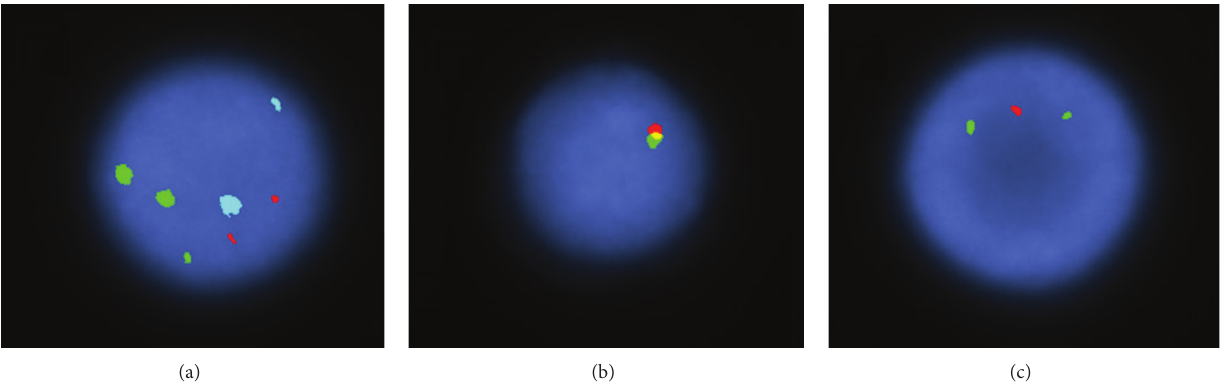
Figure 2: Fluorescence in situ hybridization (FISH) analysis. The fluorescence in situ hybridization (FISH) study for CLL was abnormal. A multiprobe panel consisting of an ATM gene at 11q22.3, a chromosome 12 pericentromeric DNA, a chromosome 13q14 putative tumor suppressor gene probe, an IgH gene, and a p53 chromosome 17 DNA probe revealed deletions of IgH and p53 genes and a trisomy for chromosome 12. Deletion of p53 is correlated with a poor prognosis. Chromosome 11 FISH results were normal. (a) Alpha 12 and 13q14 DNA probe: CEP 12 = green; 13q14 (D13S319) = red; 13q34 = aqua. (b) LSI IgH (14q32.3) Dual Color Break Apart DNA probe: normal IgH locus = yellow and side-by-side red-green. (c) ATM and p53 DNA probe: ATM (11q22.3) = green; p53 (17p13) = red.